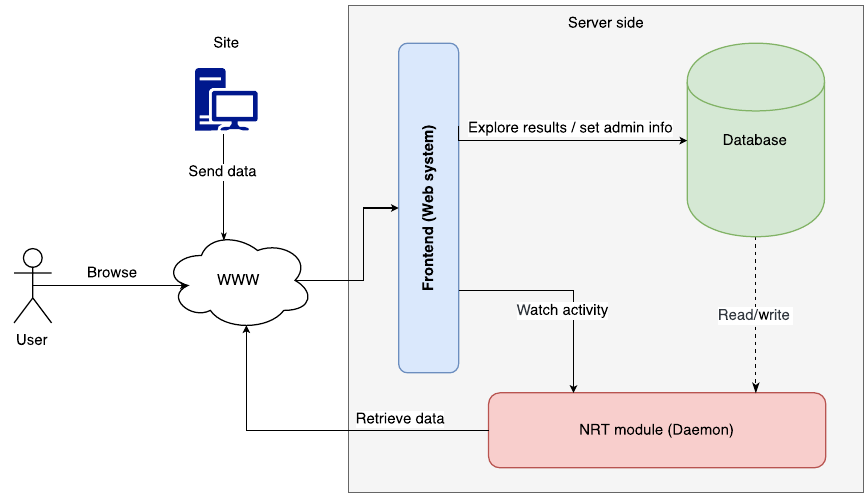
Figure 1. Diagram of CÆLIS architecture. Arrows indicate where the action is initiated (data flow is always bidirectional).